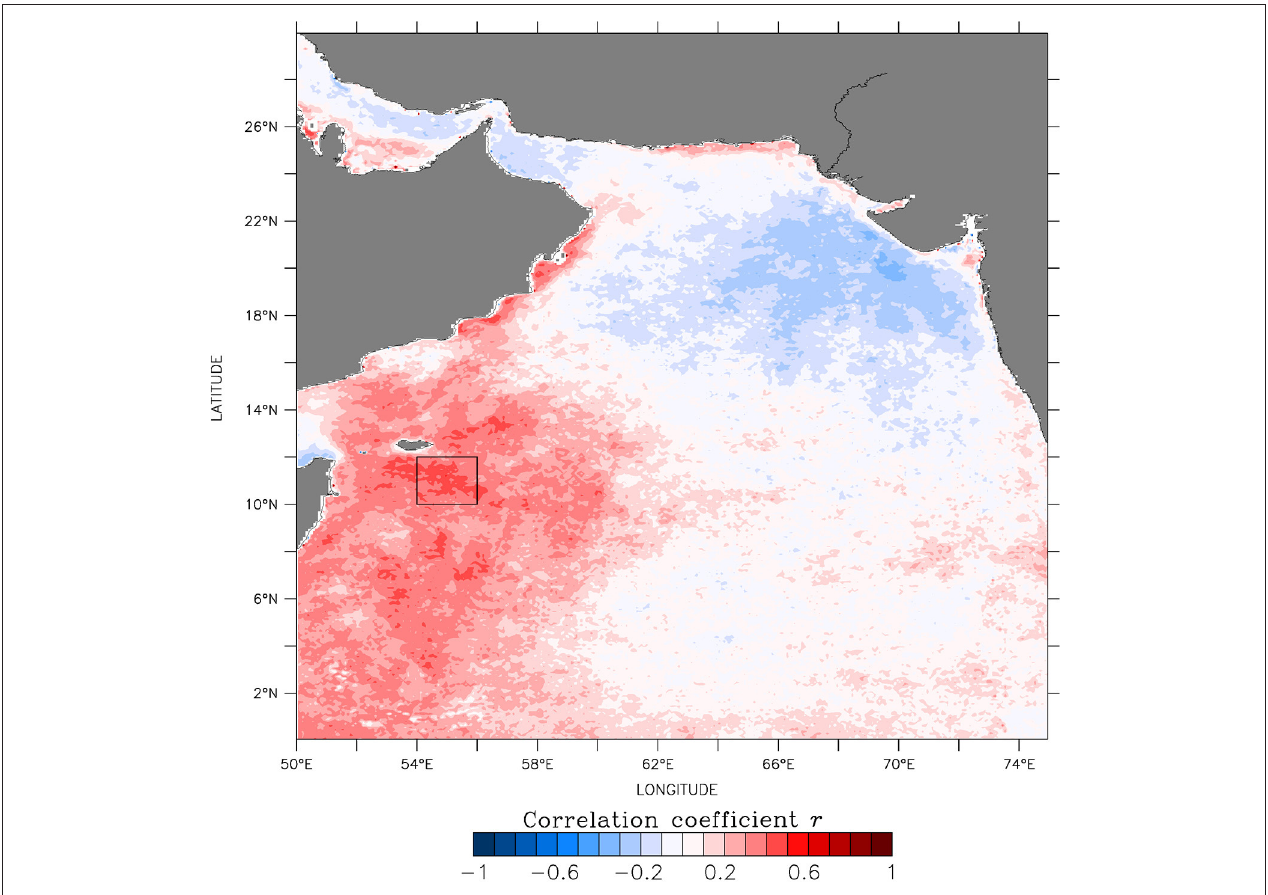
FIGURE 2 | Correlation map between 8-day composited Chl-a and NASA-AOT during 1998–2013 for the Arabian Sea. Pale to dark red shading and pale to dark blue shading represent positive and negative correlation respectively. The black square box off Somalia shows the study area selected for further